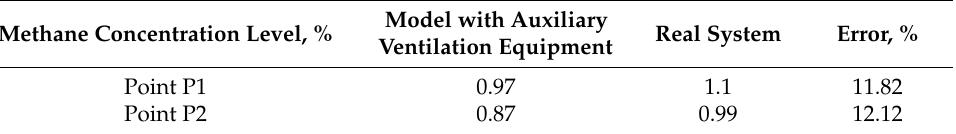
Table 4. The comparison of the methane concentration values obtained from the measurements in real-world conditions and those determined through model-based tests, for a system with auxiliary ventilation equipment (AVE).